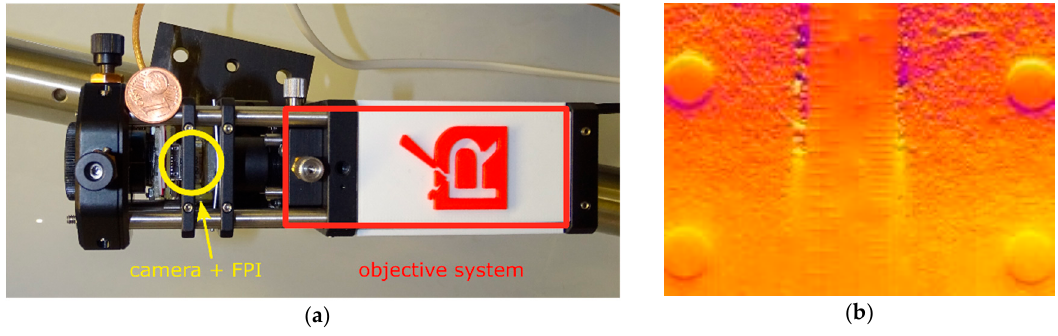
Figure 1. ( a ) Photograph of the built HSI system. The size of the camera and the FPI is compared to a 1 cent coin, which is fittingly the price of a single pixel of the bolometer camera; ( b ) Image of a sliding caliper on a breadboard recorded with the bolometer camera at a random filter position confirming the basic functionality of the optical system and the FOV of 6 × 5